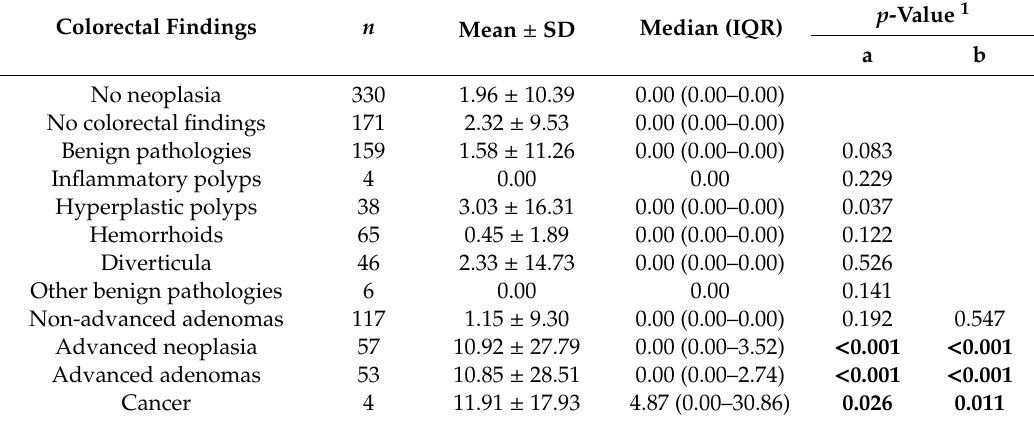
Table 1. Serum NEUROG1 methylation according to colorectal findings in the screening cohort.